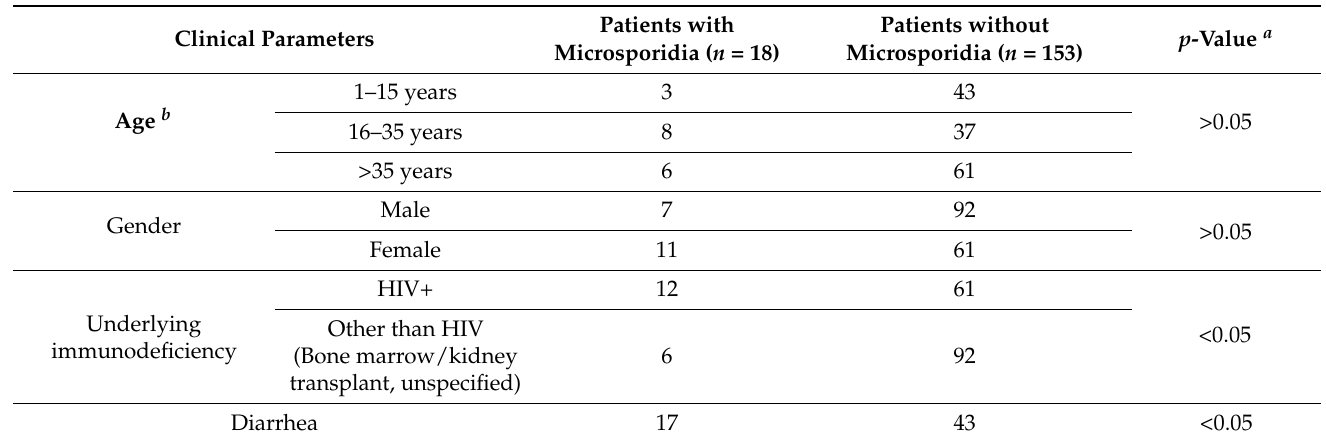
Table 1. Distribution of patients tested for intestinal microsporidia carriage according to clinical parameters (age, gender, underlying immunodeficiency, and presence/absence of